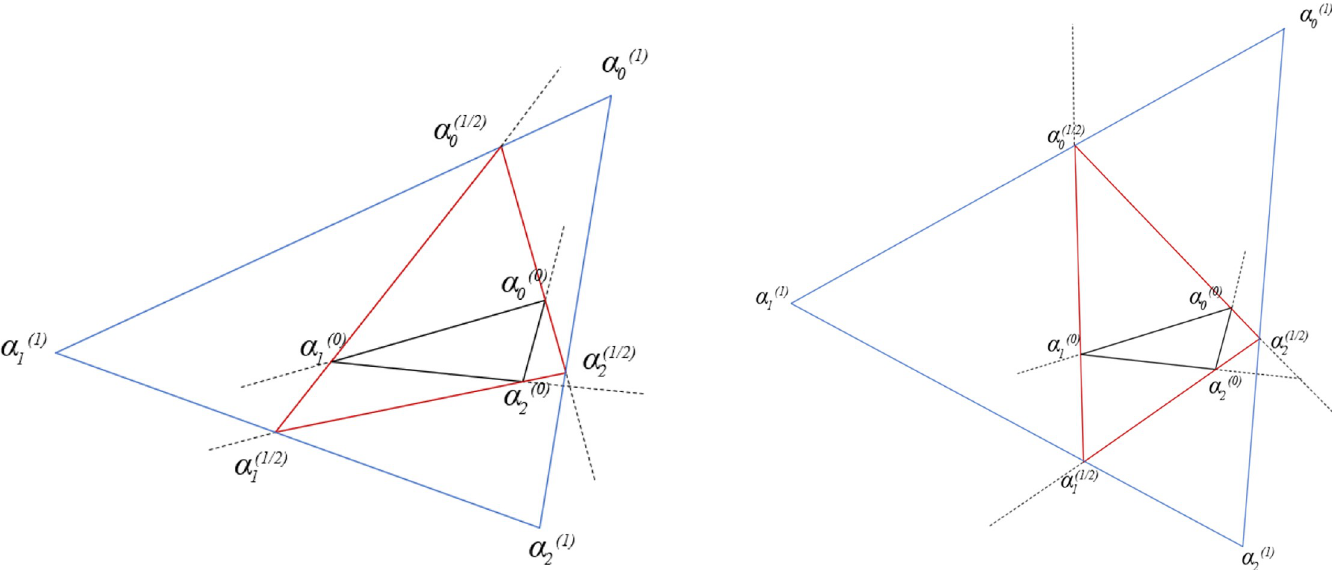
Fig 2. Operations of the first stage of EAS method for triangular mesh. a) shows EAS transformation when t is 0.25; b) shows EAS transformation when t is 0.5. Black dotted lines are extended line of directed edge; triangles of black solid line are original elements, triangles of red solid line are elements after the first substage and triangles of blue solid line are elements after the second substage.